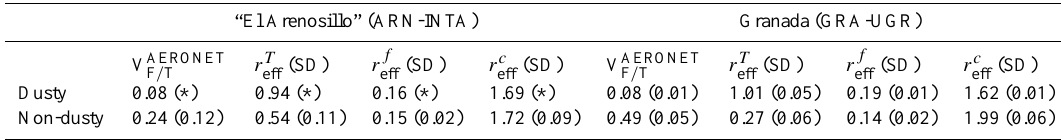
Table 3. AERONET fine-to-total mode ratio (V AERONET modes (SD denotes standard